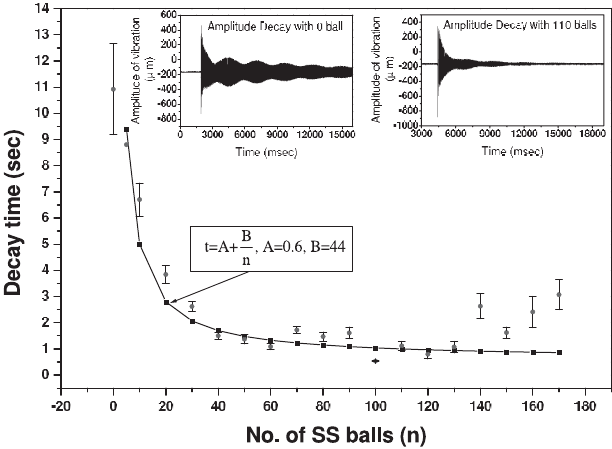
FIG. 5. Decay time of the displacement amplitude of the central conductor with the number of balls. The inside portion of the central conductor is filled with alcohol. The resonator is at room temperature and atmospheric pressure. Two inset figures show how the vibration amplitude decays with time for 0 and 110 balls.